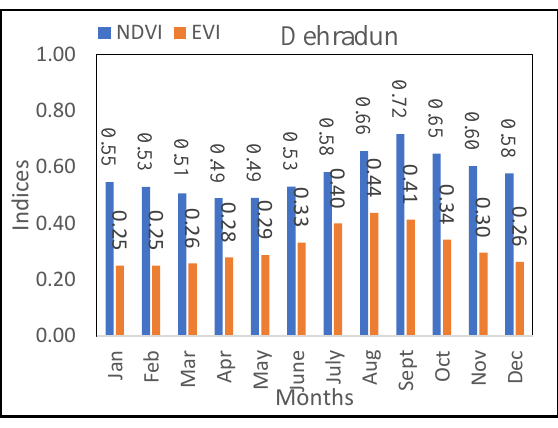
Figure 5. Champawat District Vegetation Cover (NDVI and EVI values)